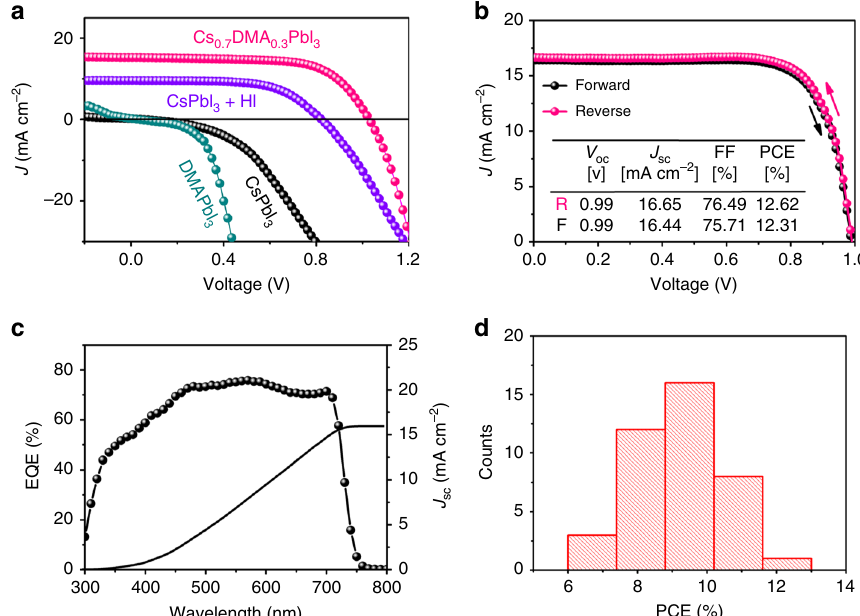
Fig. 4 Solar cell performance. a J – V curves of devices using various absorbers measured under reverse voltage scans (from V oc to 0 V). b J – V curves of the champion Cs 0.7 DMA 0.3 PbI 3 solar cell measured under different voltage scan directions. c EQE spectrum and integrated J sc of a Cs 0.7 DMA 0.3 PbI 3 solar cell. d PCE statistics for 40 Cs 0.7 DMA 0.3 PbI 3 solar